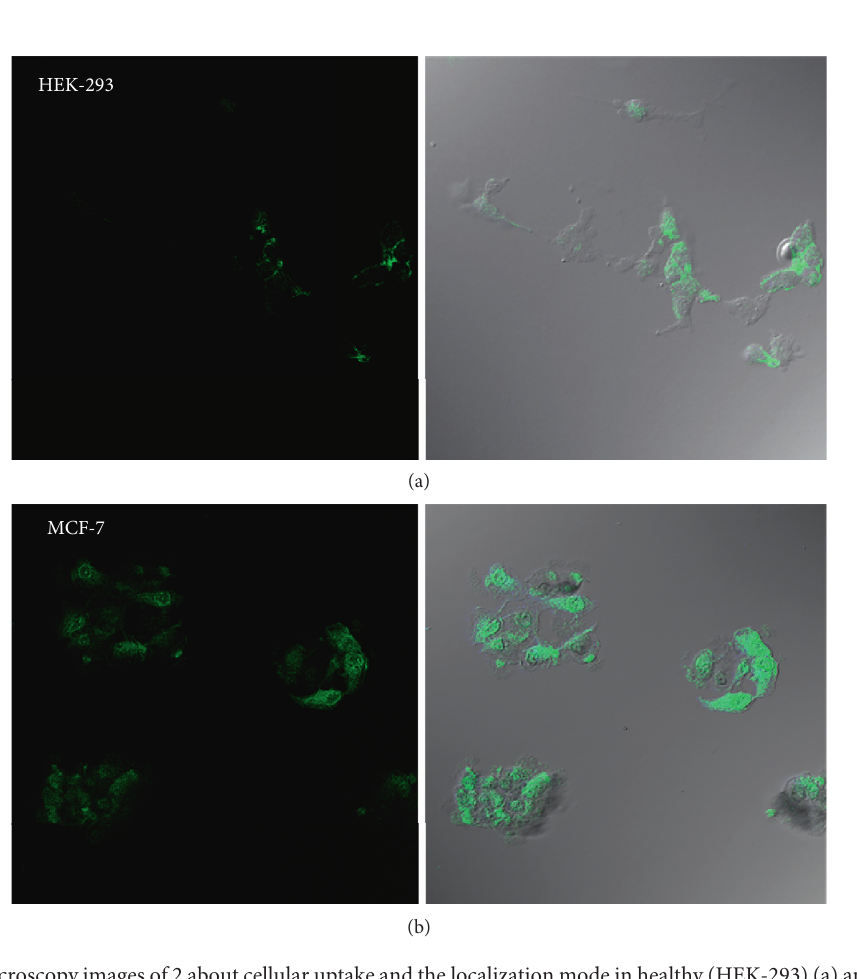
Table 7: In vitro activity of 1, 2, and cis-platin (expressed as IC Complexes